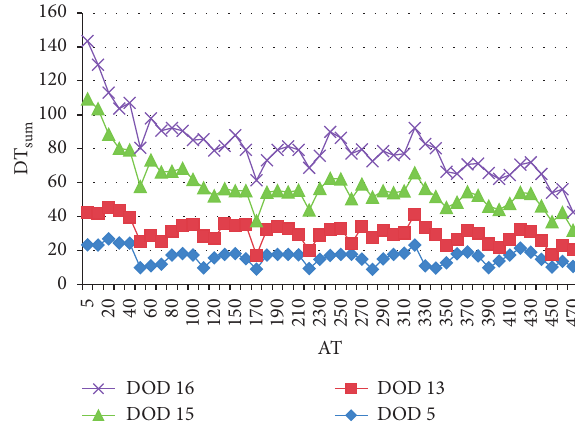
Figure 5: Trends of zero-inventory time for one strike.